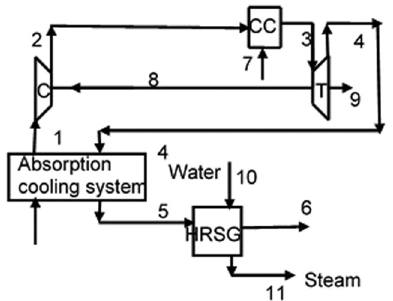
Figure 1: Diagram of a bsc cogeneration cycle.